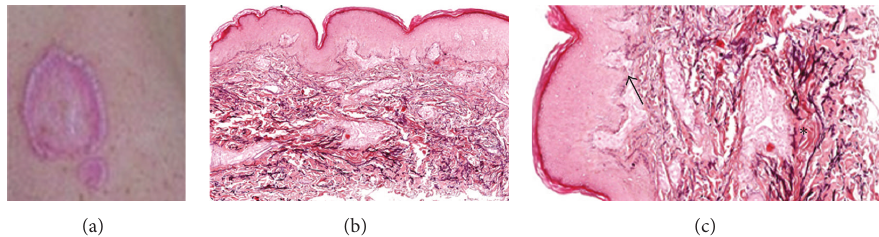
F 12: Elastosis perforans serpiginosa. Hyperkeratotic plaques of papules in the neck of a patient (a). LM examination with degenerated elastic �bers (b, c, asterisk) and transepidermal perforating canals (b, c, arrowed,